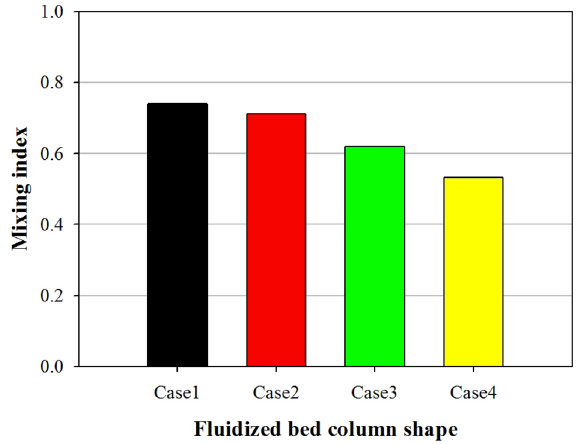
Figure 13. Mixing index for different shapes of fluidized bed